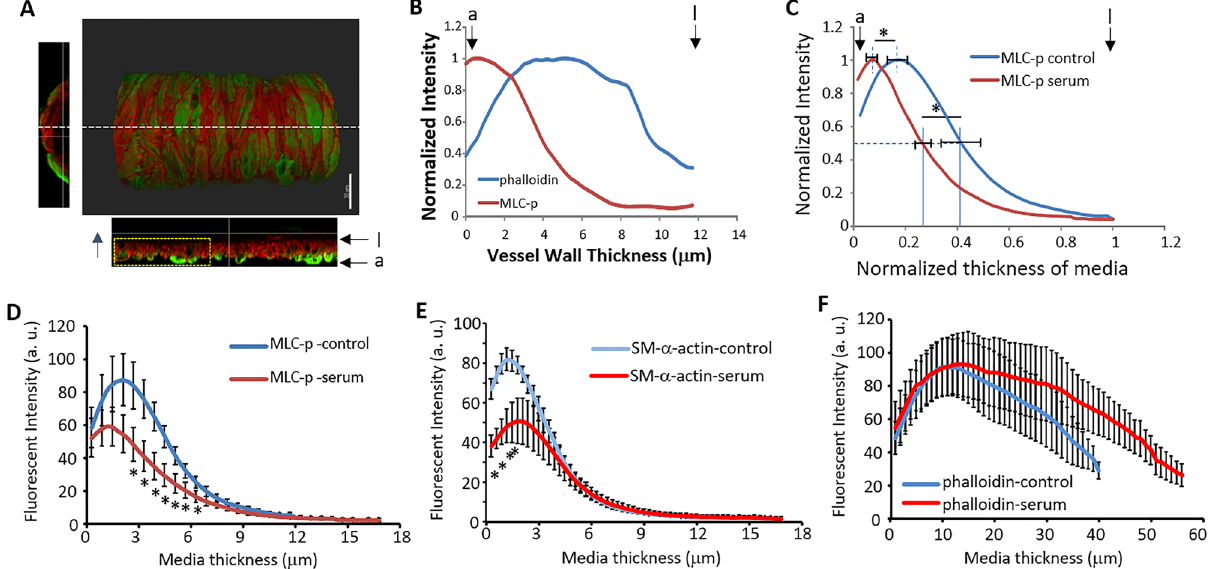
Figure 4. Comparison of the staining patterns for MLC-p, SM-α-actin and phalloidin between control and serum constricted SCA. ( A ) 3D longitudinal view of an immuno-labeled SCA vessel, green-MLC-p, red- phalloidin. White dashed line depicts the plane where a longitudinal orthogonal section was taken, the normal view of the longitudinal section is shown in the bottom image. The section of vessel outlined by the yellow box was used to analyze the intensity profile of MLC-p and phalloidin-labeling across the vessel wall in the direction depicted by the blue arrow , Scale bar = 30 μm. ( B ) The graph depicts the normalized intensity profile of MLC-p and phalloidin of the vessel orthogonal section shown in ( A ), a: depicts adventitia side of vessel wall; l: depicts intra-luminal side of vessel wall. ( C ) At 70 mmHg, the vasoconstriction induced by 10% rat serum is accompanied by a shift of the MLC-p profile to the left (e.g. towards the adventitial edge) of the smooth muscle layer. Dashed line indicates the level of half-maximum intensity; the mean ± SEM of N vessels is indicated by the horizontal bar for each curve. a: depicts adventitia side of vessel wall; l: depicts intra-luminal side of vessel wall. ( D ) Comparison of fluorescence intensity of MLC-p in the smooth muscle layer. Data are presented as Mean ± SEM. ( E ) Comparison of fluorescence intensity of SM-α-actin in the smooth muscle layer of control and serum treated SCA. Mean ± SEM. ( F ) Comparison of fluorescence intensity of phalloidin labeled actin filaments in the smooth muscle layer of control and serum treated SCA. Mean ± SEM. * p < 0.05, n = 6 for control and serum treated arteries respectively. a.u.: arbitrary